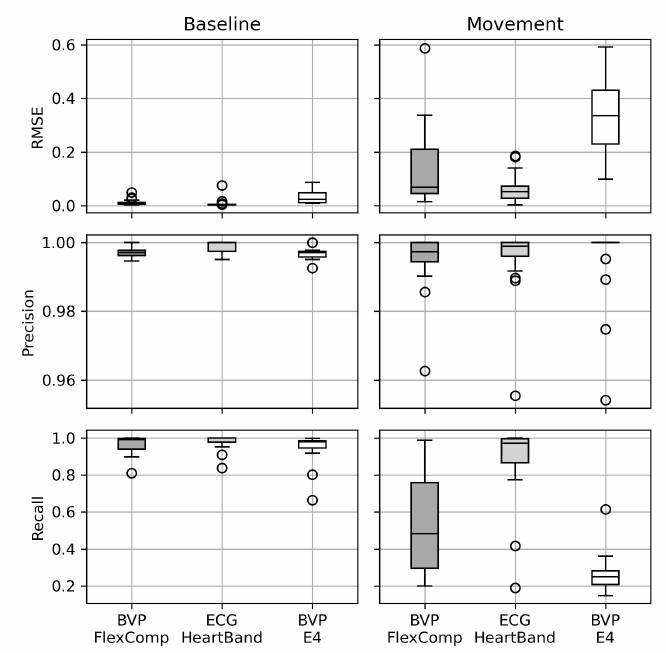
Figure 5. Metrics of the quality of the inter-beat intervals extracted from the cardiac signals.